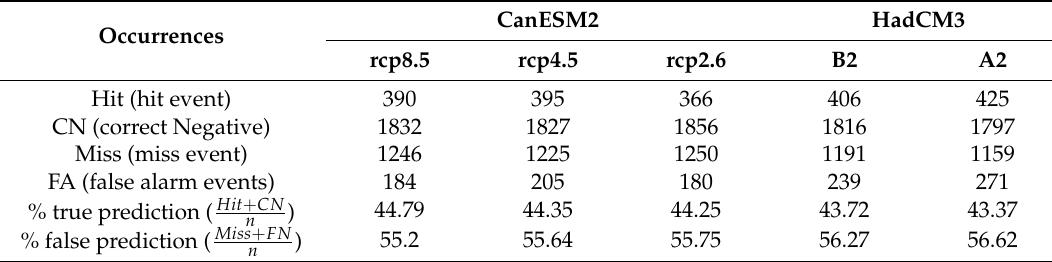
Table 8. Occurrence of precipitation under the used